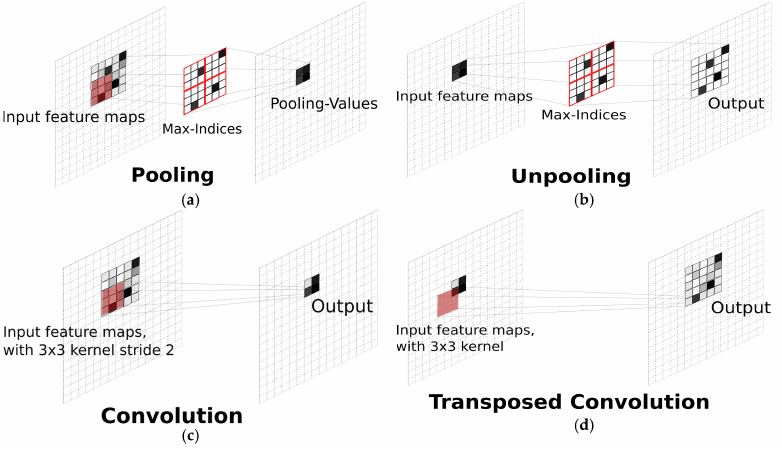
Figure 14. Illustration of ( a ) pooling, ( b ) unpooling, ( c ) convolution, and ( d ) transposed convolution operations in NN models. Reprinted from ref.